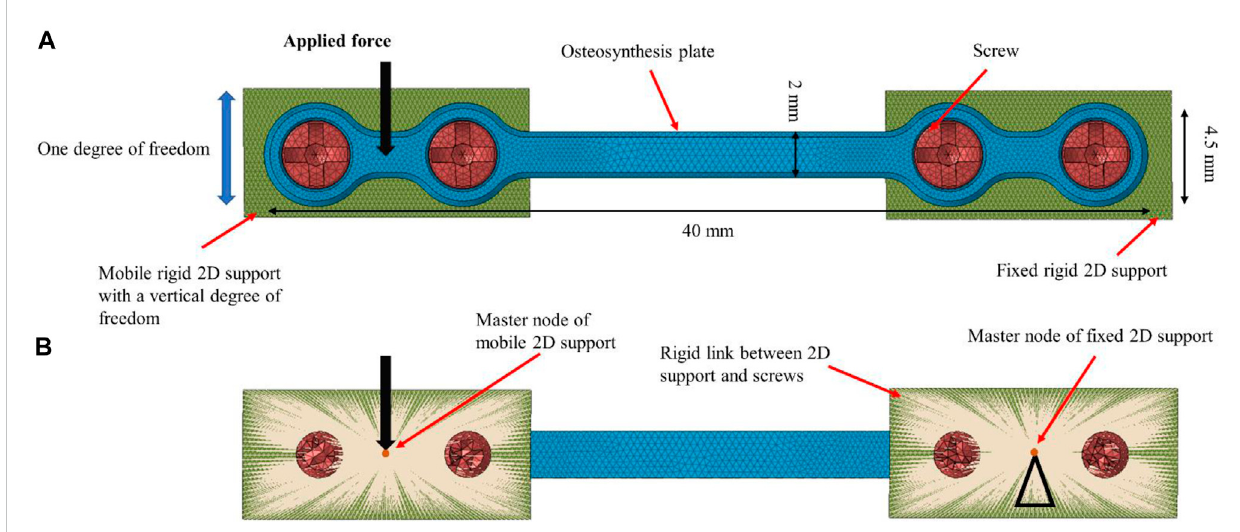
FIGURE 4 Finite element model of osteosynthesis plate (40 × 4.5 × 1 mm). (A) : Front view and (B) : back view. The screws were fi xed to the 2D supports using rigid links. A force was applied to the master node of the left 2D support, while the right 2D support was fully constrained. The contact between the plate and screws was modeled as sliding.